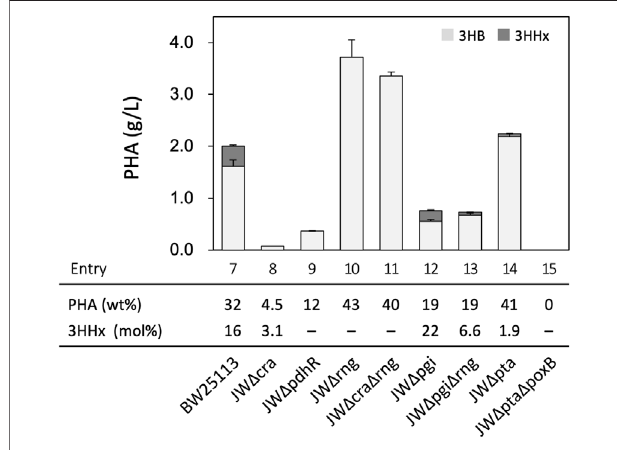
FIGURE 4 | Effects of mutation(s) on sugar metabolism-regulating genes and acetate formation on P(3HB- co -3HHx) biosynthesis from glucose by E. coli BW25113-derived recombinant strains harboring pBKS-PCJAB/pBtac-CJ Re E/pSTV-HCB. The amounts of 3HB and 3HHx units in PHA are shown in gray and black bars, respectively.